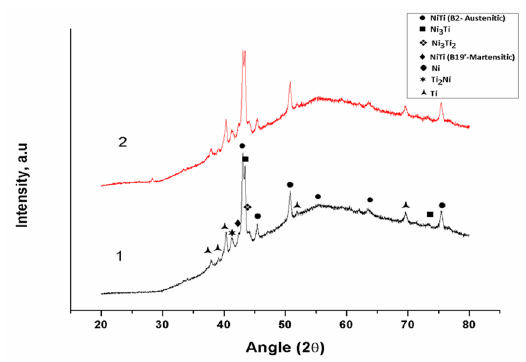
Figure 3. XRD patterns of samples processed under conditions 1&2